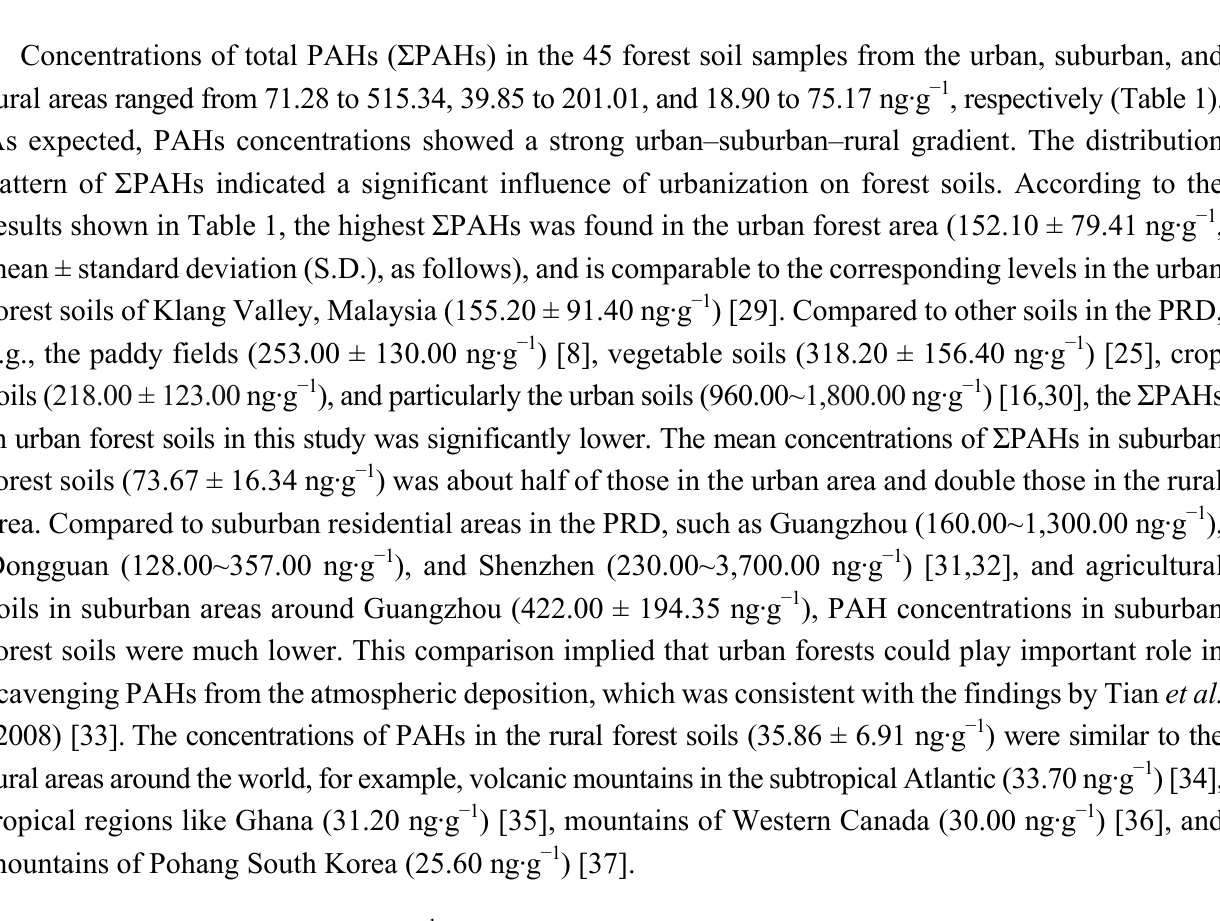
Table 1. Concentrations (ng·g − 1 dry weight) of PAHs in forest soils in urban, suburban, and rural